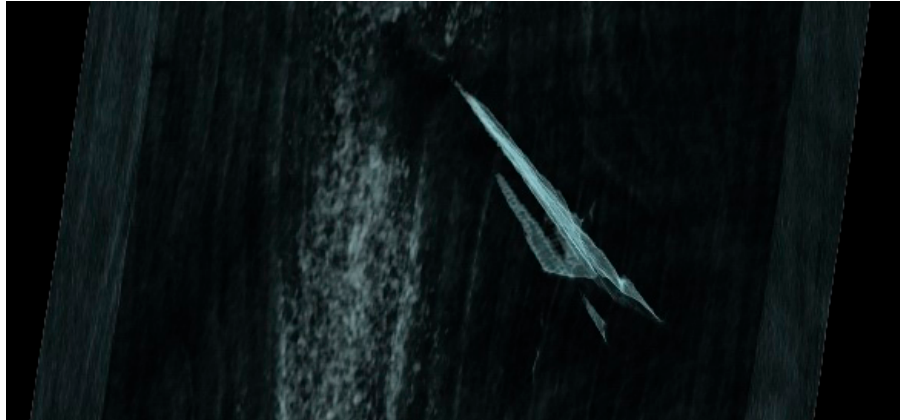
Figure 8. Demonstration of the identification of a knot inside a test sample and its exact position (range) through volume rendering technique.